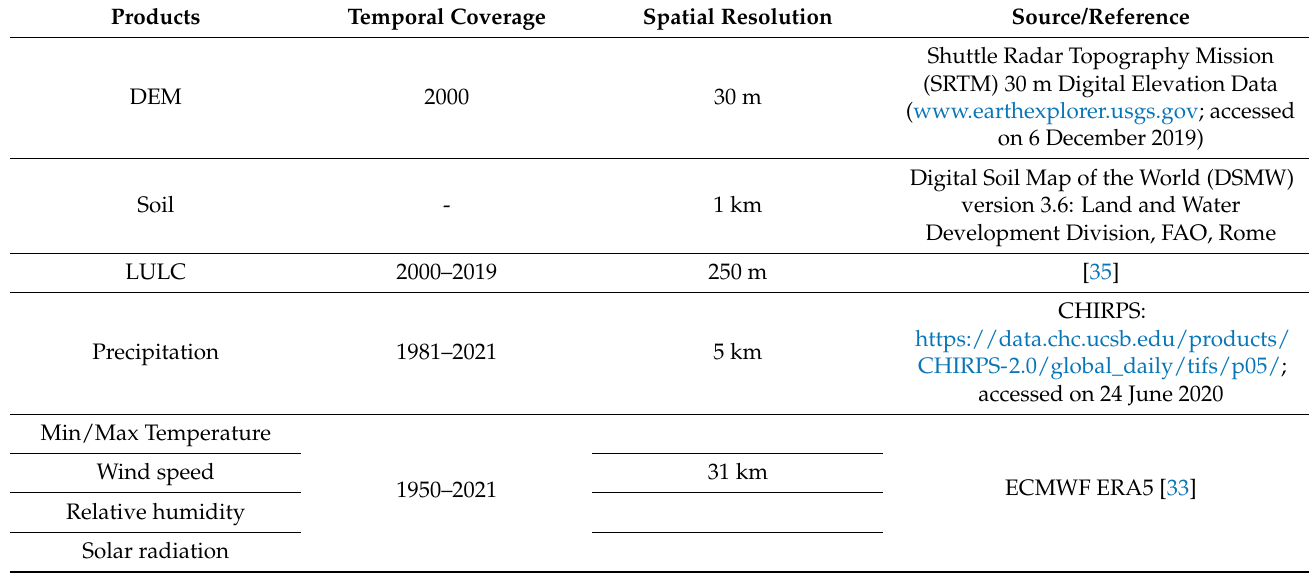
Table 2. Description of forcing data used in the SWAT model in this study.